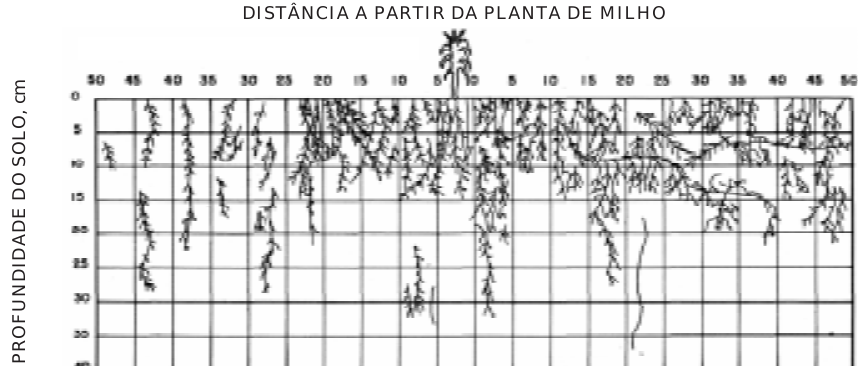
Figura 2. Distribuição radicular do milho em solo sob preparo convencional não pastejado.